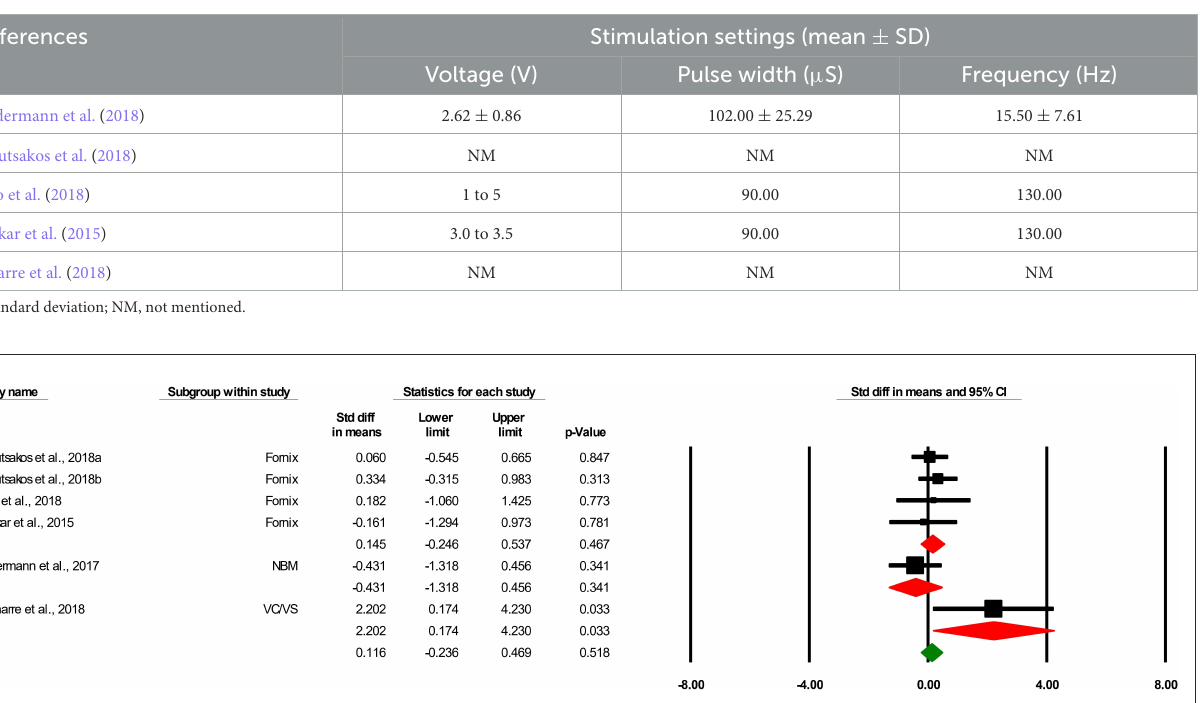
TABLE 2 The stimulation parameters in the included studies.